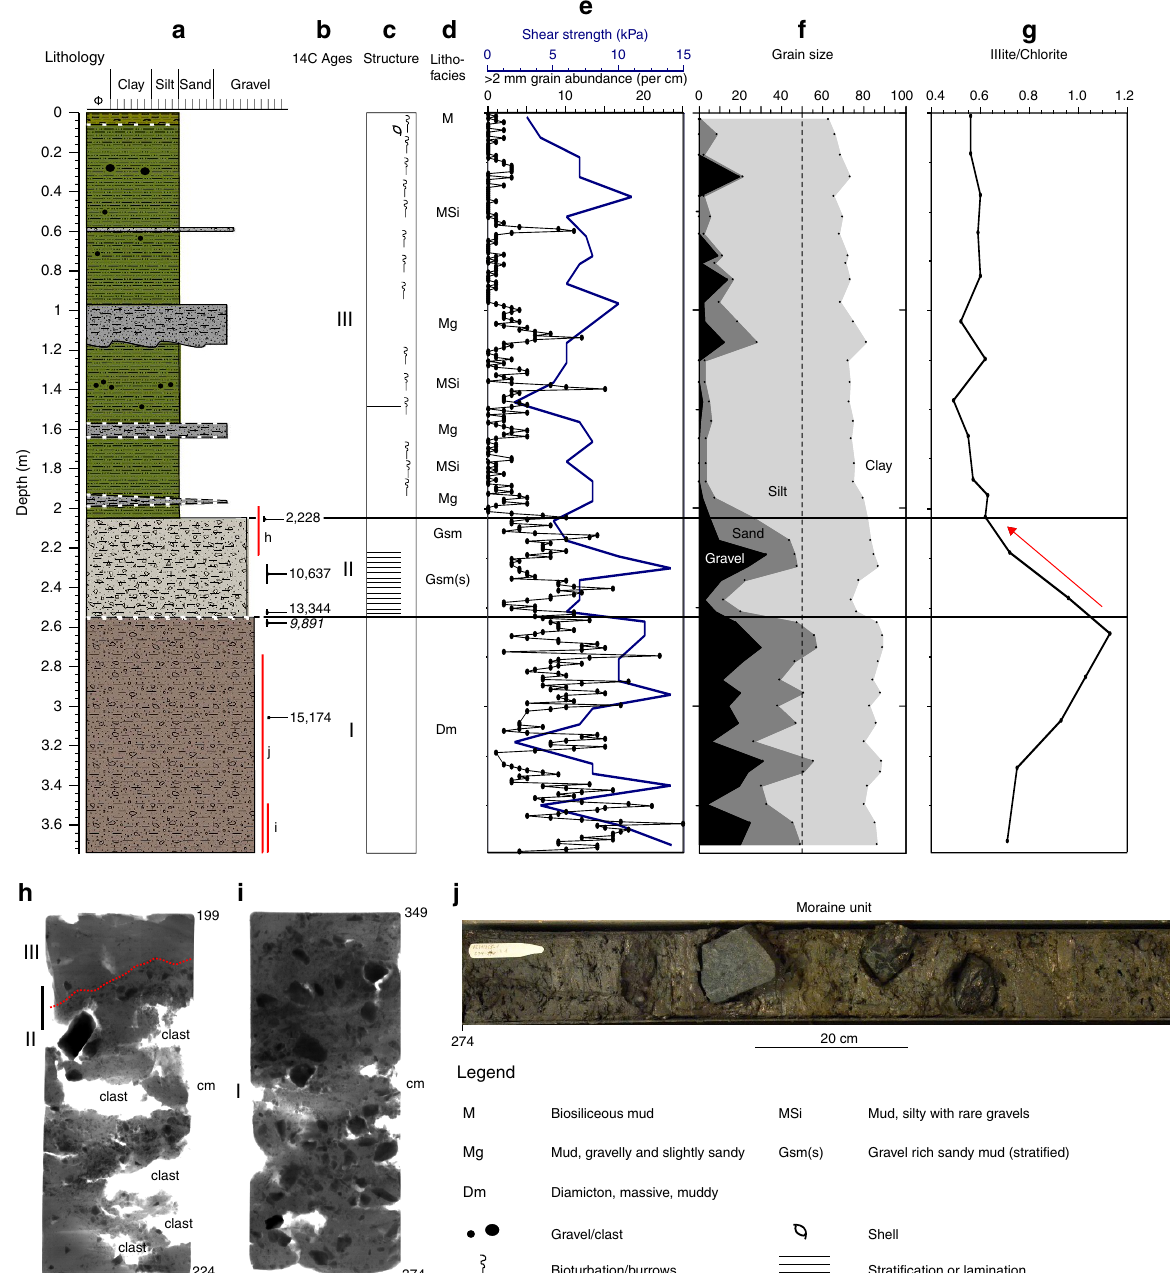
Figure 6 | Sediment logs and properties for core PS81/265-1 through moraine M2. ( a ) Lithological log showing key units and dominant grain size. Colours used to distinguish units and are representative, ( b ) AMS 14C ages, ( c ) sedimentary structures, ( d ) lithofacies, ( e ) shear strength data (blue), grain abundance 4 2mm per 10cm 3 (black dots), ( f ) grain size percentages, and ( g ) the Illite/Chlorite ratio in the clay ( o 2 m m fraction). ( h , i ) X-radiographs showing massive structure of the gravel-rich units. Black bar in ‘ h ’ shows location of sample for dating, red line shows boundary between units ( j ) core photograph of a section of the lowermost ‘moraine unit’ (lithological Unit I) illustrating large angular clasts in homogenous matrix. Legend relates to panels a – d